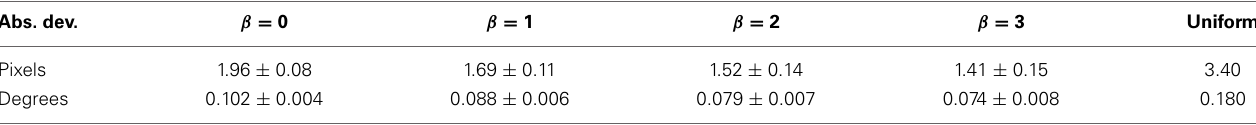
Table 2 | Localization accuracy.